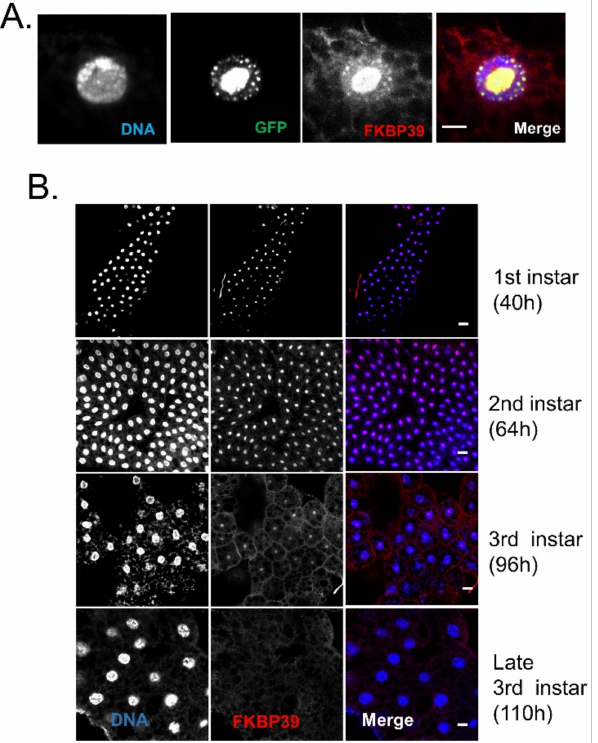
Figure 2. The nuclear localization pattern of FKBP39 in the fat body. ( A ) The fat body from CG-GAL4; UAS-GFP-FKBP39 were dissected and stained with FKBP39 antibody (red). ( B ) Different stages of fat bodies were stained with FKBP39 antibody (red) and DAPI (blue). Bar: 10 µ